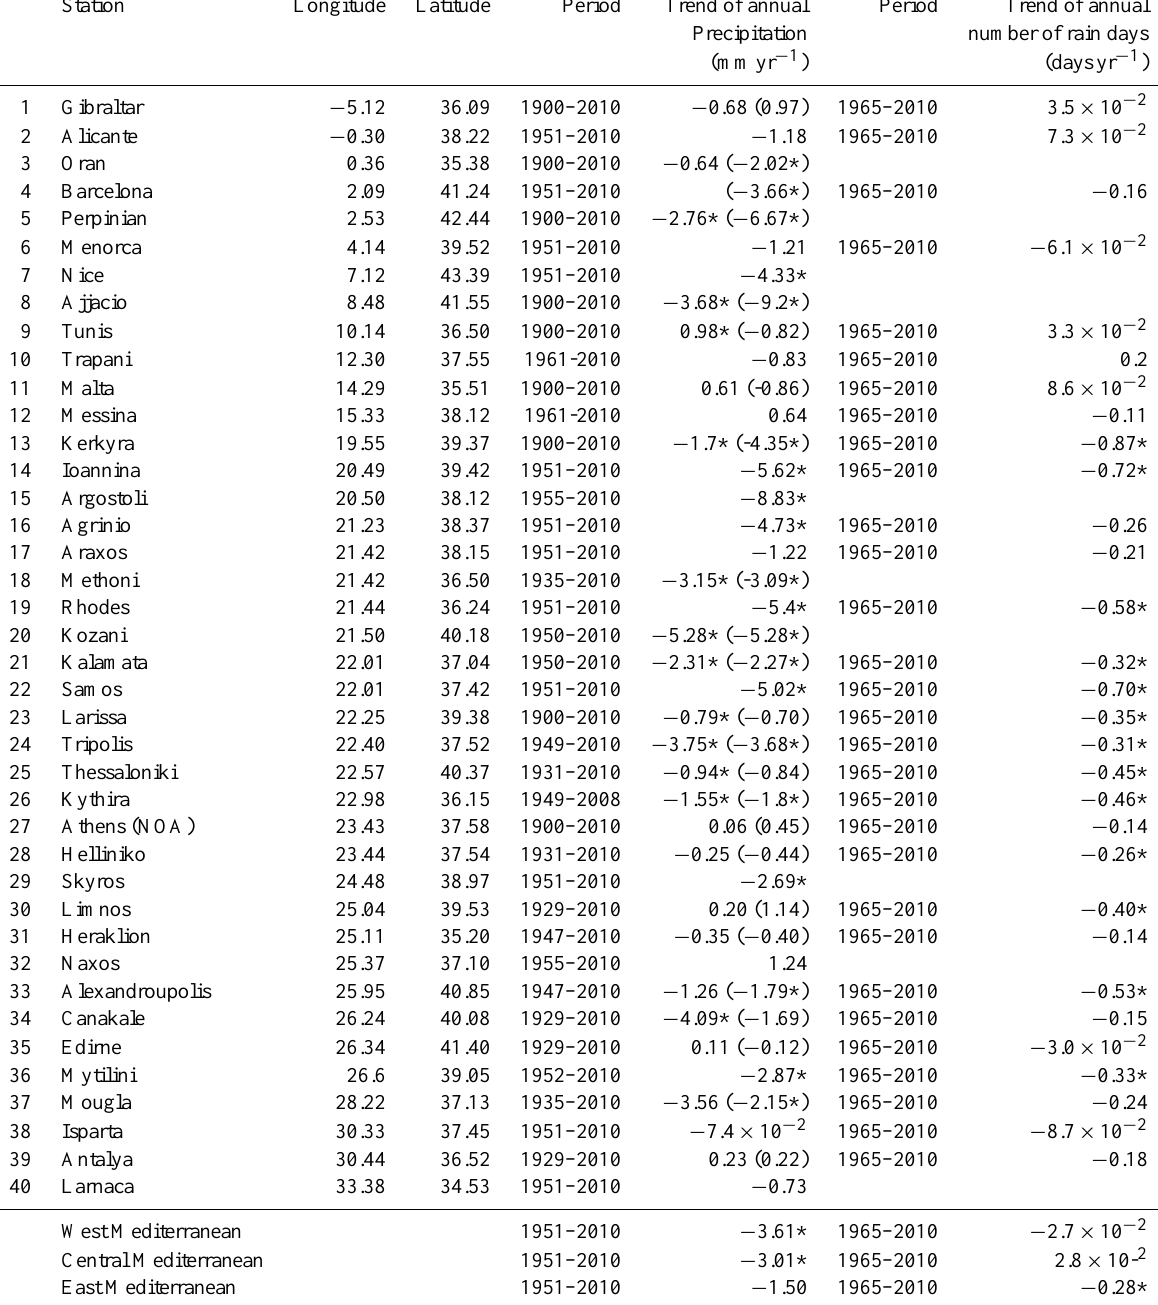
Table 1. Trends of annual precipitation totals and annual number of rain days. The figures in brackets concern trends of annual precipitation totals during the 1951–2010. The asterisk (*) denotes statistically significant figures at 95% confidence level. Column 5 refers to the available period of recorded annual precipitation and column 7 to the available period of annual number of rain